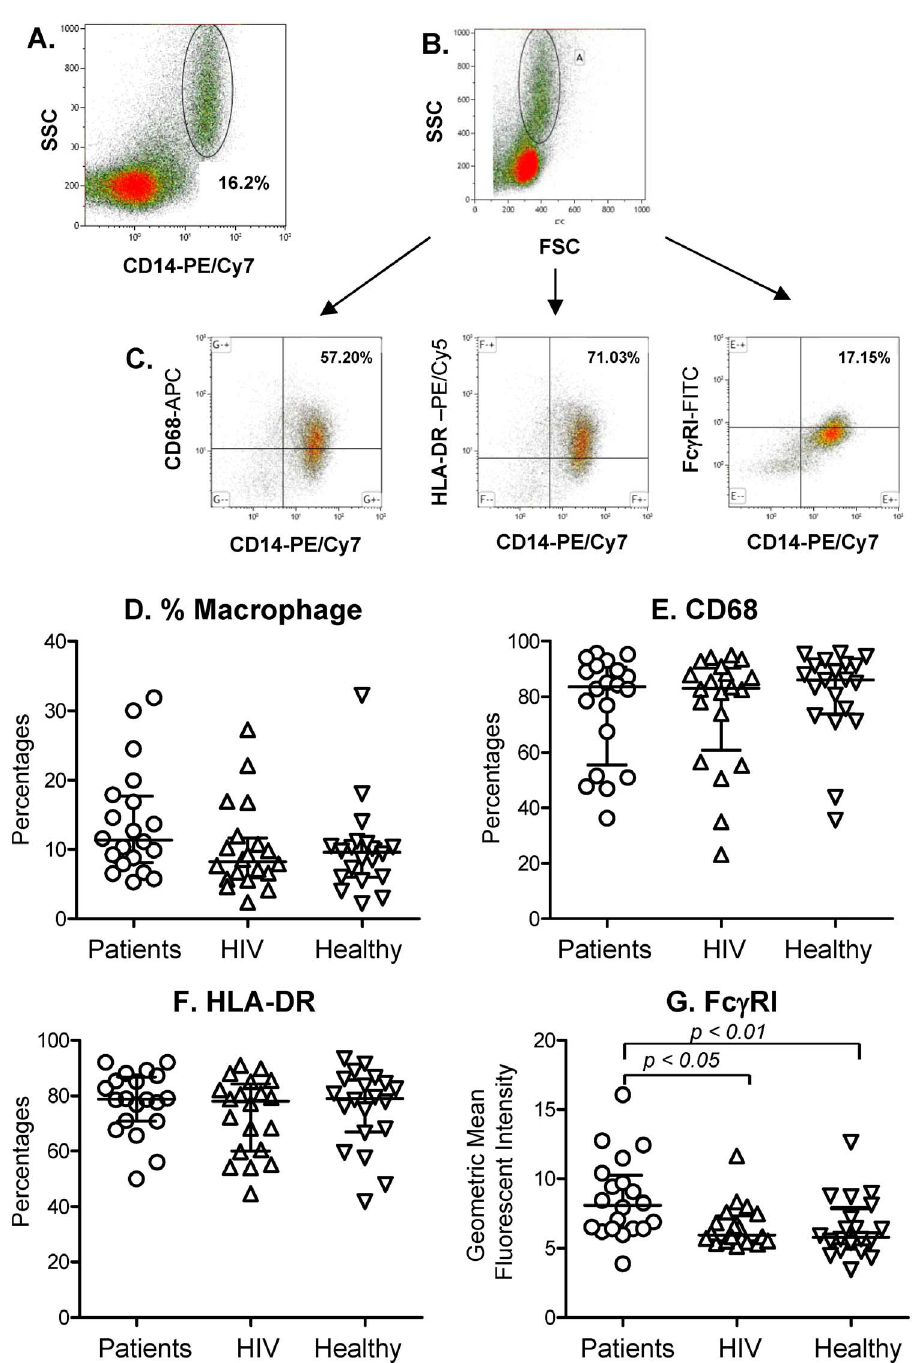
Figure 1. Flow cytometric characterization, frequencies, and function of macrophages. PBMCs were stained with fluorochrome- conjugated anti-CD14, CD68, HLA-DR, and Fc c R1. Monocyte/macrophage populations were identified by gating forward, side scatter, and CD14 + (A). Gates were then set on monocyte population on forward scatter and side scatter dot plot (B) and analyzed for the expression of CD68, HLA-DR and Fc c RI in relation to CD14 expression (C). Figures show the percentages of (D) macrophages overall, (E) macrophages expressing CD68, (F) macrophages expressing HLA-DR, as well as (G) the mean fluorescent intensity of Fc c R1. Symbol represents the data of each individual case patient (circles), HIV + control (up-pointing triangles), and healthy control (down-pointing triangles). Horizontal long lines show the medians, and short lines the interquartile ranges of each group. Indicated p values for comparisons are by Kruskal-wallis one-way analysis of variance by rank test. doi:10.1371/journal.pone.0110276.g001 of PBMCs of cases to produce iNOS was normal (data not Cytokine production shown). There were no statistically significant differences between cases and controls in fold increases for the percentages CD4 and CD8 T